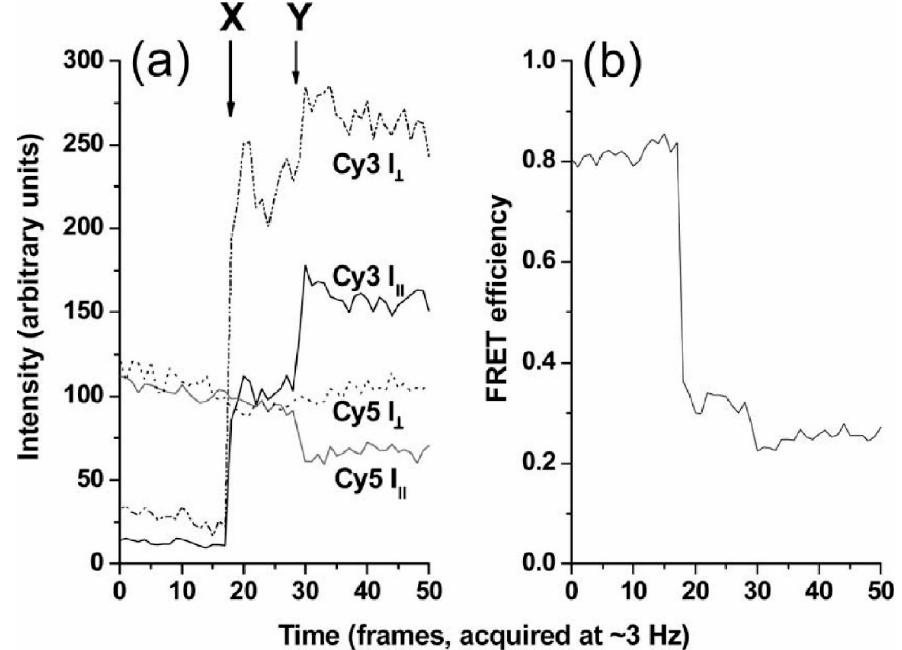
Figure 7. Polarization-resolved single-pair FRET in live cells, taken from Webb et al. [91]. ( a ) Temporal variation of polarization and wavelength-resolved intensity from EGF–Cy3 and EGF–Cy5 molecules bound to EGFR in A431 cells; ( b ) Corresponding variation in FRET efficiency.